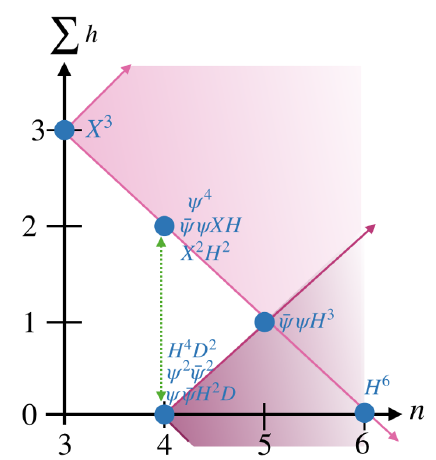
Figure 1 . The classes of dimension 6 SMEFT operators, plotted according to the number of legs n , and total helicity, Σ h , of their corresponding tree-level amplitudes. The diagram can be reflected about the n axis by Hermitian conjugation to obtain the full set of operators. Pink cones delineate operators that can be renormalised by the operators at the apex of the cone. The green dotted line indicates exceptions to this rule due to SM amplitudes containing a product of two different Yukawa